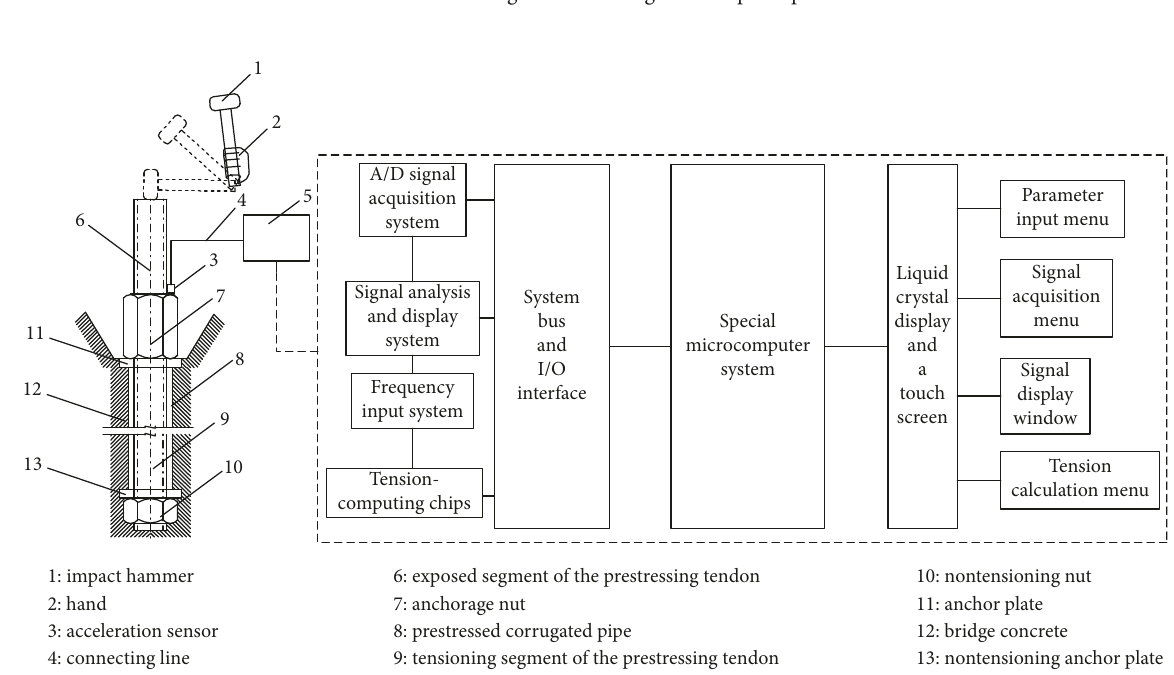
Figure 17: Schematic view of test and block diagram of the